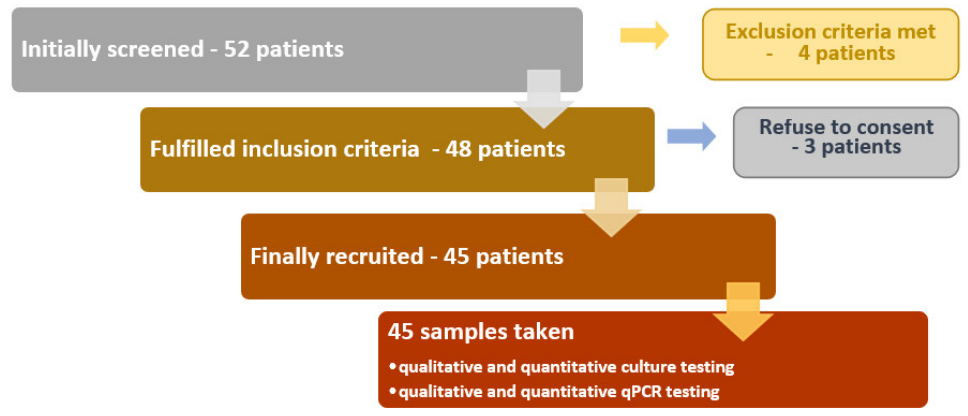
Figure 1. Flowchart of study recruitment.